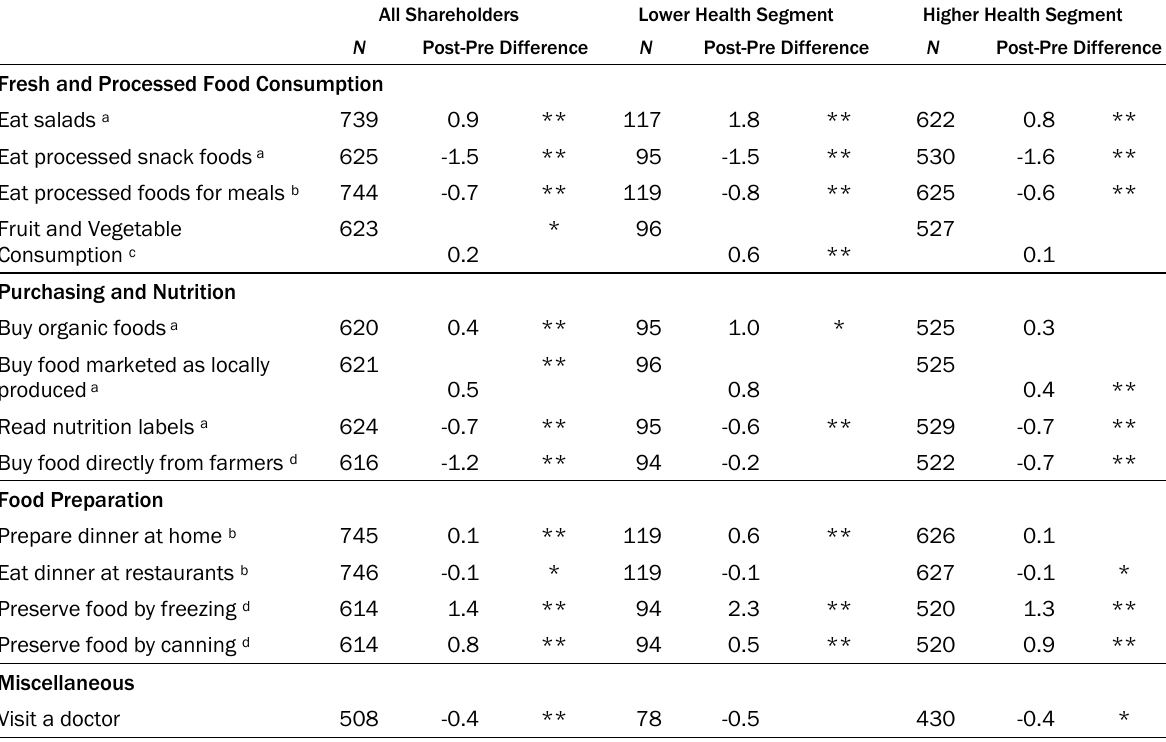
Table 3. Perceptions of Behavior Change Frequency Following CSA Participation All